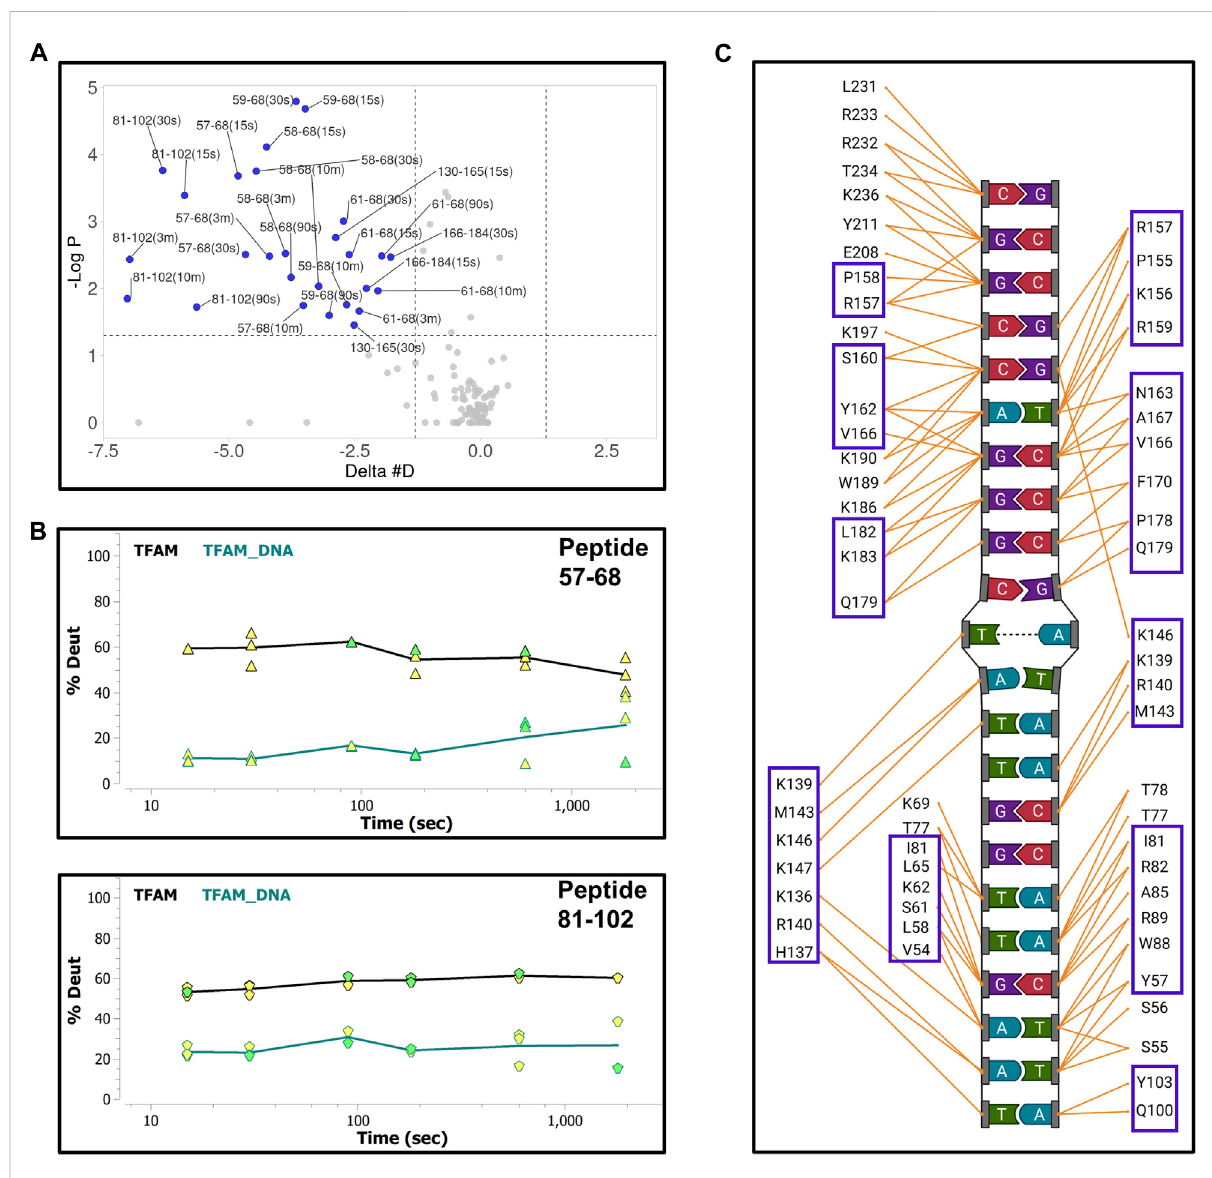
FIGURE 5 Hydrogen-deuterium exchange of the TFAM-DNA complex reveals the regions of TFAM involved with DNA binding. (A) Volcano plot quantifying the signi fi cant change in deuteron uptake for each peptide at a given time point. The upper left quadrant of the plot displays peptides (solidbluecircles)withasigni fi cantdecreaseindeuteronuptakeoftheTFAM-DNAcomplexrelativetoTFAMalone.Thissigni fi canceisbasedontwo statistical tests performed by the HDExaminer software where the fi rst is a p -value test with a signi fi cance cutoff value of < 0.05 (i.e., at a con fi dence level of 95%) and the second is based on whether the difference value on the X -axis (Delta #D) is greater than the replicate variance across all of the data within each speci fi c data set as determined by the program. (B) Representative uptake plots are shown from the HDX-MS time course for peptides 57 – 68 and 81 – 102 that are signi fi cantly different between the TFAM-DNA and TFAM samples based on the volcano plot in (A) . (C) Interaction map showing TFAM residues that interact with DNA in the crystal structure of the TFAM-DNA complex (PDB ID:4nnu). Blue boxes represent residues within peptides that display a signi fi cant decrease in deuteration observed in the volcano plot.